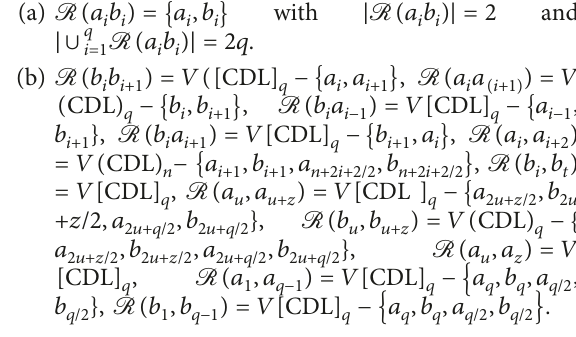
Table 2: RN sets and the elements of [ DSF ] RN set